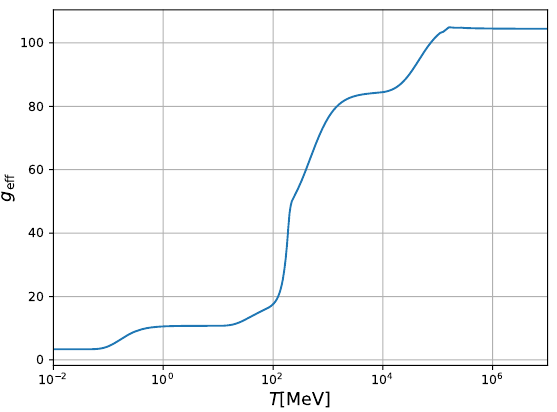
Figure 3: This figure shows the effective number of relativistic degrees of freedom g of a Standard Model plasma as a function of temperature, taking into account eff interactions between particles, with both perturbative and lattice methods [ 24 ]